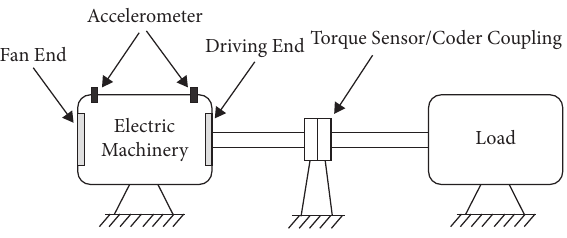
Figure 6: Schematic diagram of the experimental represents the correlation coefficient of the reconstructed signal and the original no-noise signal. The signal-to-noise ratio is defined as SNR � 10 × lg ( P s / P n ) , where P s and P n represent the intensity of the noise-free signal and noise, respectively.